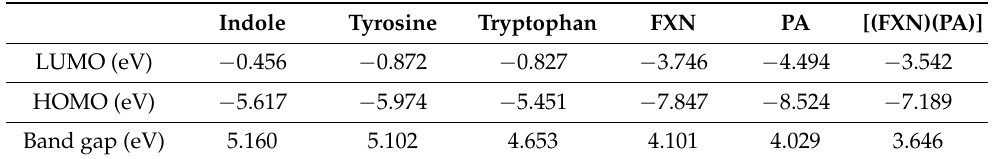
Table 4. HOMO and LUMO energies calculated for tyrosine, tryptophan, FXN, PA, and [(FXN)(PA)] at B3LYP/6-311G++ levels of theory.